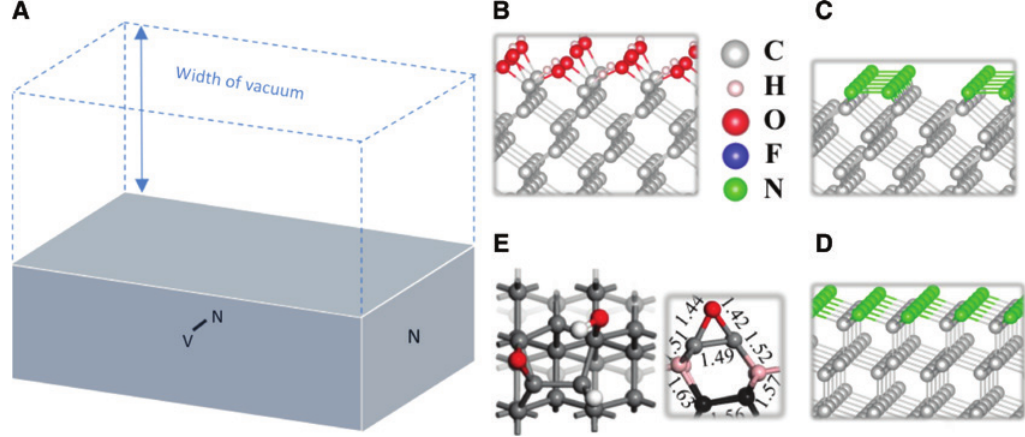
Figure 4: (A) Schematic diagram of the slab modeling of point defects at the surface: NV is an acceptor, whereas N is a donor. The entire slab is neutral. (B) Proposed smooth oxygenated (100) diamond surface for NV sensor applications. (C) Nitrogen-terminated (100) diamond surface. (D) Nitrogen-terminated (111) diamond surface. (E) Mixed oxygen-terminated (113) diamond surface with an epoxy C–O–C bonding configurations shown also from the side view with typical bondlengths in Ångström unit. Data were taken from Refs. [78, 120,